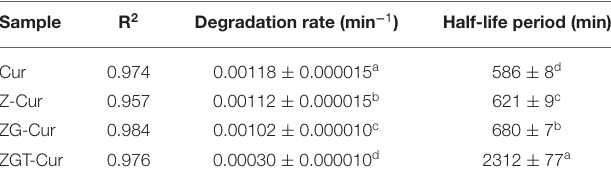
TABLE 1 | Parameters of the first-order model for curcumin degradation during UV irradiation. Sample